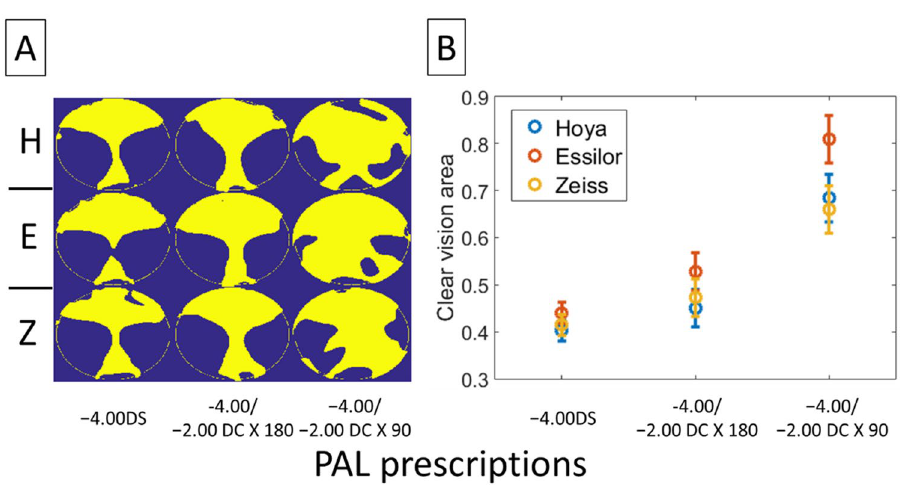
Figure 8. Area of clear vision for different PALs, metric � J α . ( A ) Binary image showing area of clear vision (yellow) and area with � J α more than ± 0.25D from the target prescription (dark blue). The calculations in each plot were based on data of four lenses with the same prescription. H Hoya, E Essilor, Z Zeiss. ( B ) Proportion of clear vision area as a function of PAL prescription. The proportion was calculated as the area of clear vision to the total area of measurement. Error bars represent standard